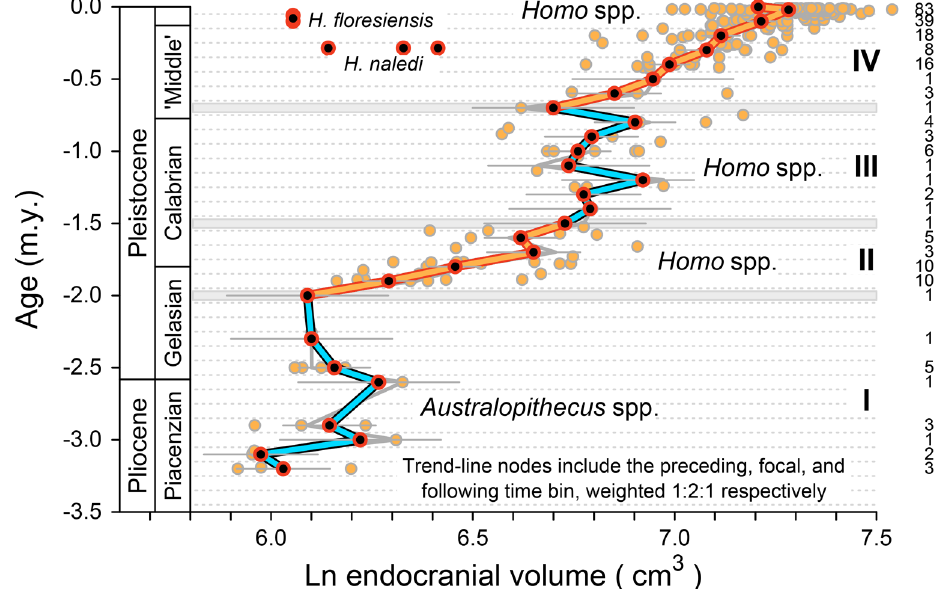
Figure 3. Brain size evolution in the broad lineage of Plio-Pleistocene hominins leading to modern humans, aggregated on a time scale of 0.1 million years (100 k.y.). Points in the background are the 233 hominin ECV values representing 98 geological ages shown in Fig. 1 (Supplementary Dataset 1). Gray zigzag line in the background traces mean ln ECV values for each 100 k.y. time bin through 28 successive bins. Blue and yellow lines in the foreground trace a 1:2:1-weighted running mean of ln ECV values for the 28 time bins (plus a modern sample). Sample sizes for each bin are listed in the right-hand column. Four phases of change are evident: I, in blue, an initial phase of relatively stationary brain size; II, in yellow, an early phase of increasing brain size; III, in blue, a second phase of relatively stationary brain size; and IV, in yellow, a second phase of increasing brain size. Phases are compared statistically in Fig.